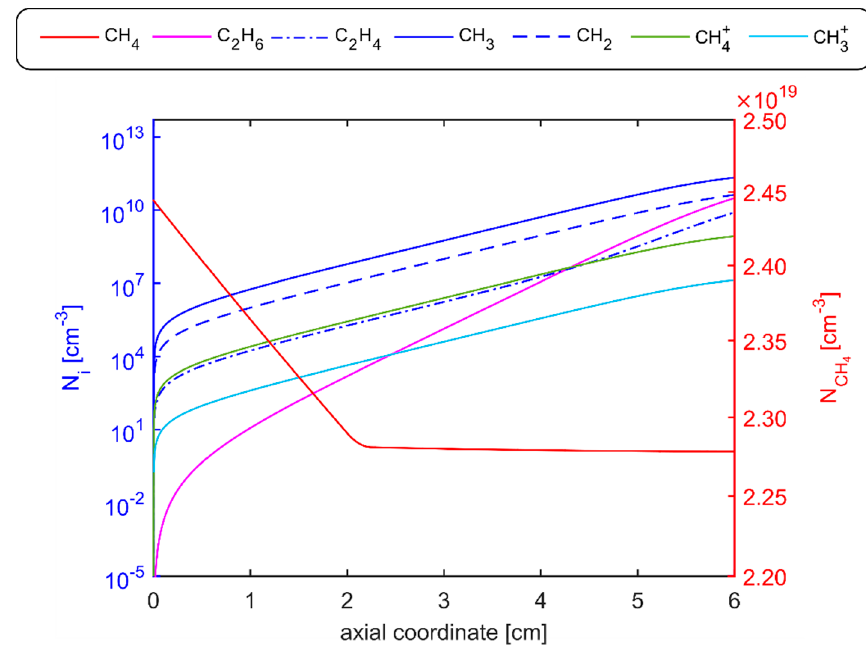
Figure 9. Axial profile of the number density predicted by the PFR model: production of C 2 H 6 , C 2 H 4 , CH 3 , CH 2 , CH (cid:2872)(cid:2878) , and CH (cid:2871)(cid:2878) on the left axis; CH 4 consumption on the right axis.